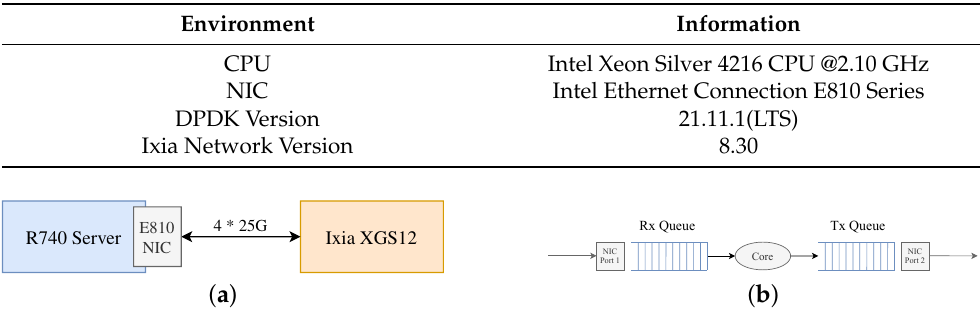
Table 1. The Detailed Experimental Configurations.